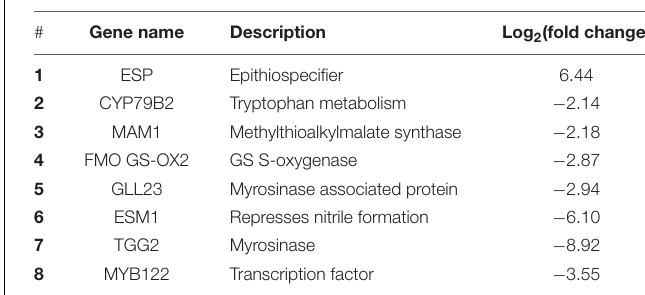
TABLE 2 | Differentially expressed genes involved in GS biosynthesis, regulation, and hydrolysis in the iqd1-1 line, as compared to WT